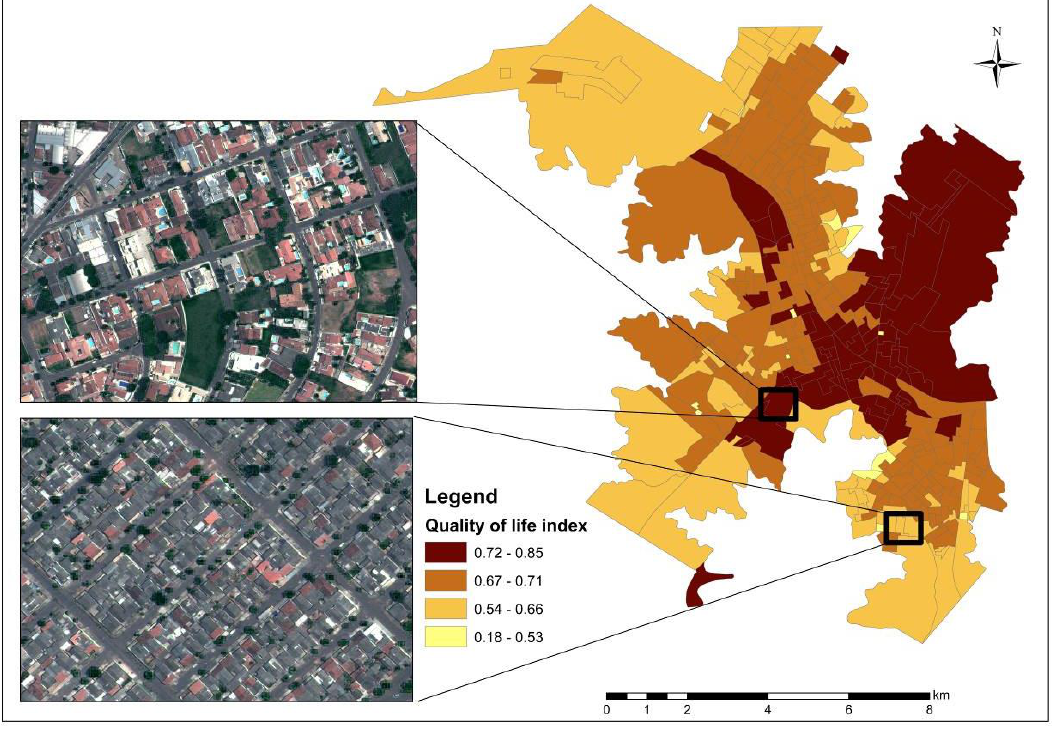
Figure 10. Illustration of the relationship among the arboreal vegetation, residential pattern, and QOLI.